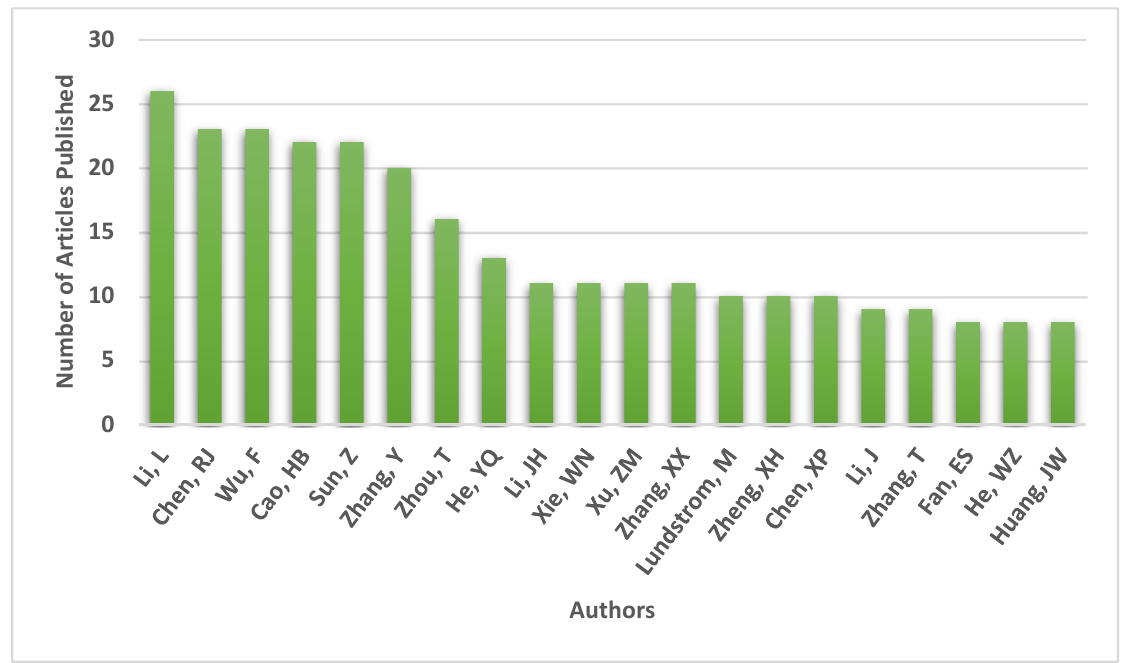
Figure 13. The 20 most published authors in the selected database.